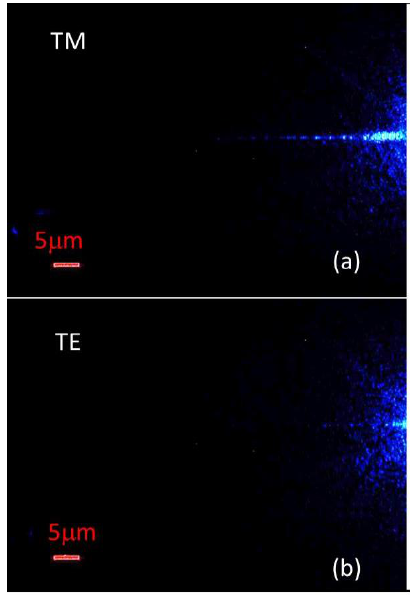
Figure 4. TM light propagation through experimentally fabricated straight Luneburg waveguide: ( a , c ) Microscopic images of the fabricated Luneburg waveguide taken at different magnifications. ( b , d ) Microscopic images of the same waveguide regions taken while 488-nm light was coupled into the waveguide. Double periodicity of light distribution in the waveguide is indicated by arrows in frames (c) and (d).